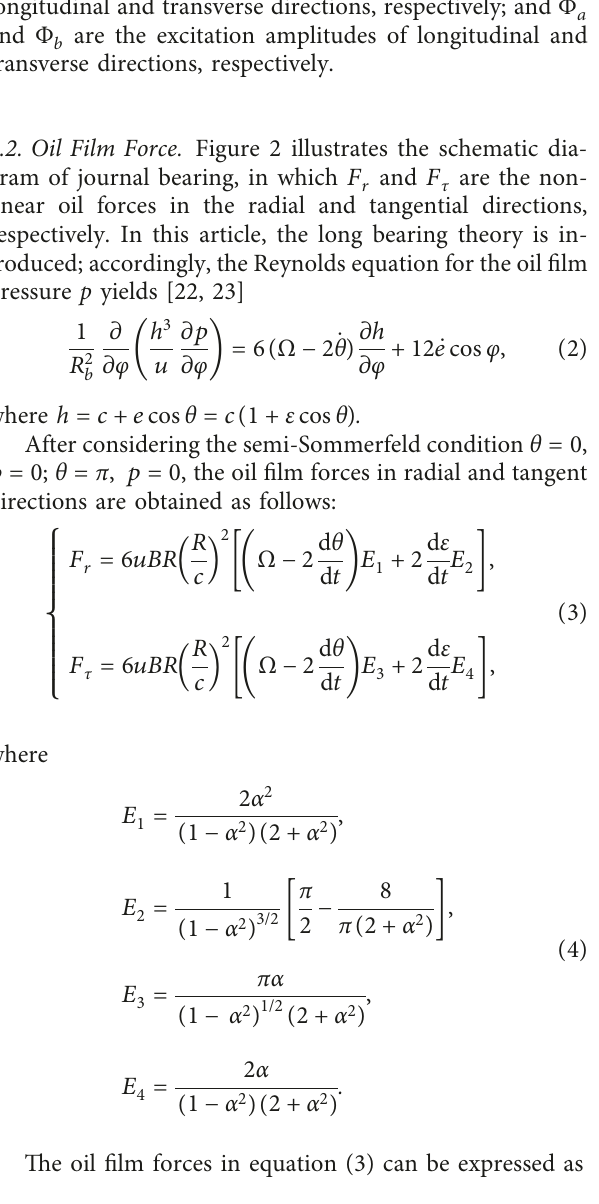
Figure 2: Schematic diagram of journal